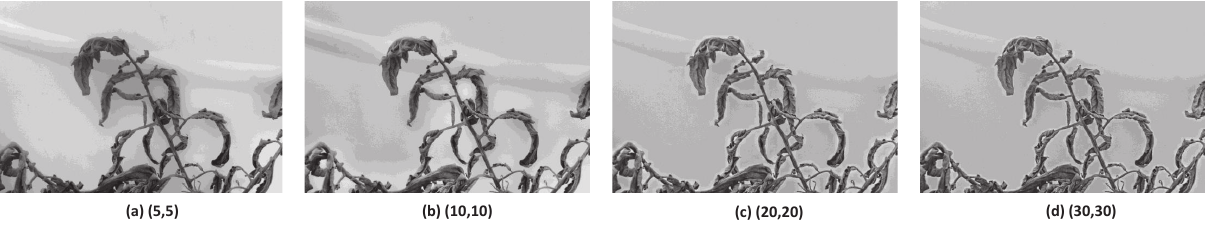
Figure 6. CLAHE outputs with the clip limit set to 2 and the grid sizes of 5, 10, 20, and 30